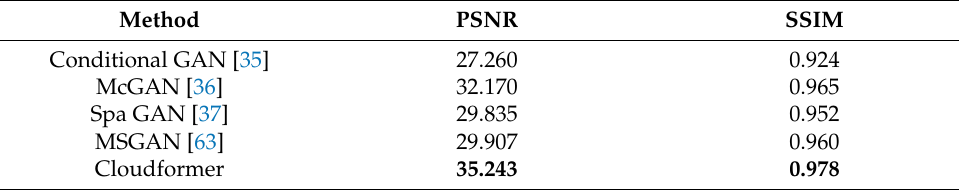
Figure 10. Comparative experimental results on the second sample of RICE1. MSGAN produces obvious false patches in the upper left and right of the close-up. The results of McGAN and Spa GAN show a certain color deviation. The texture features of the results of conditional GAN are relatively blurred and cannot reproduce image details well. In contrast, our method not only maintains the correctness of the color but also clearly preserves the texture characteristics of the image. Table 3. Quantitative evaluation on